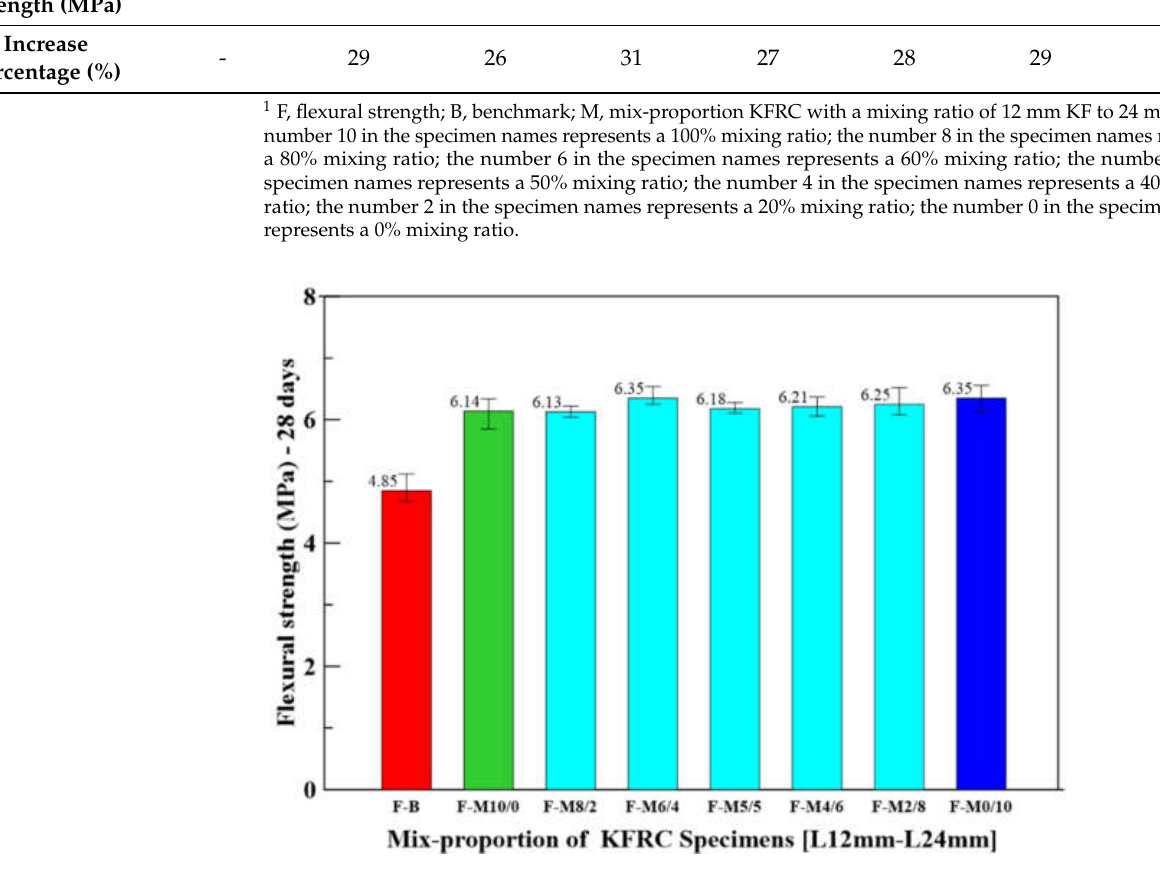
Table 9. Flexural strengths of the benchmark and mix-proportion KFRC specimens.